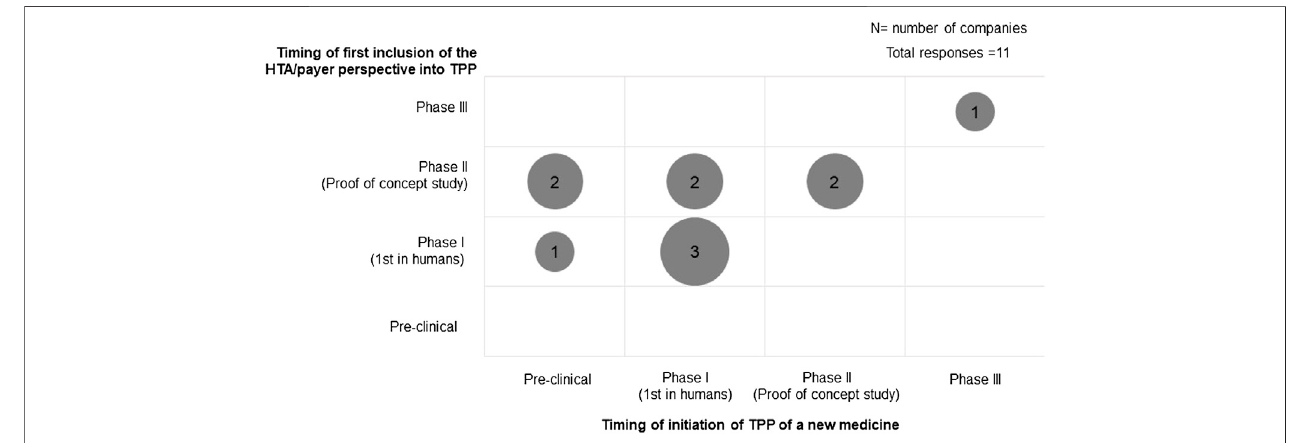
FIGURE 1 | Timing of the initiation of TPP development and inclusion of HTA/payer perspectives.